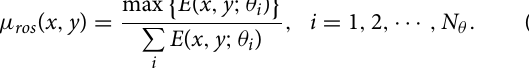
orientation-selective surround inhibition cells, and then processed by the non-selective surround inhibition cells. The ROS map µ ros ( x , y ) (defined by Equation 15) determines the contribution of each type of cells at each location. For example, the orientation-salient region of grating receives stronger orientation-selective inhibition and weaker non-selective inhibition; the non-orientation-salient region of random bars is quite the reverse. The widths of the connections from the surrounding cells to CRF cells in Model 2 indicate the synaptic strengths: the thicker the connections, the stronger the synaptic strengths